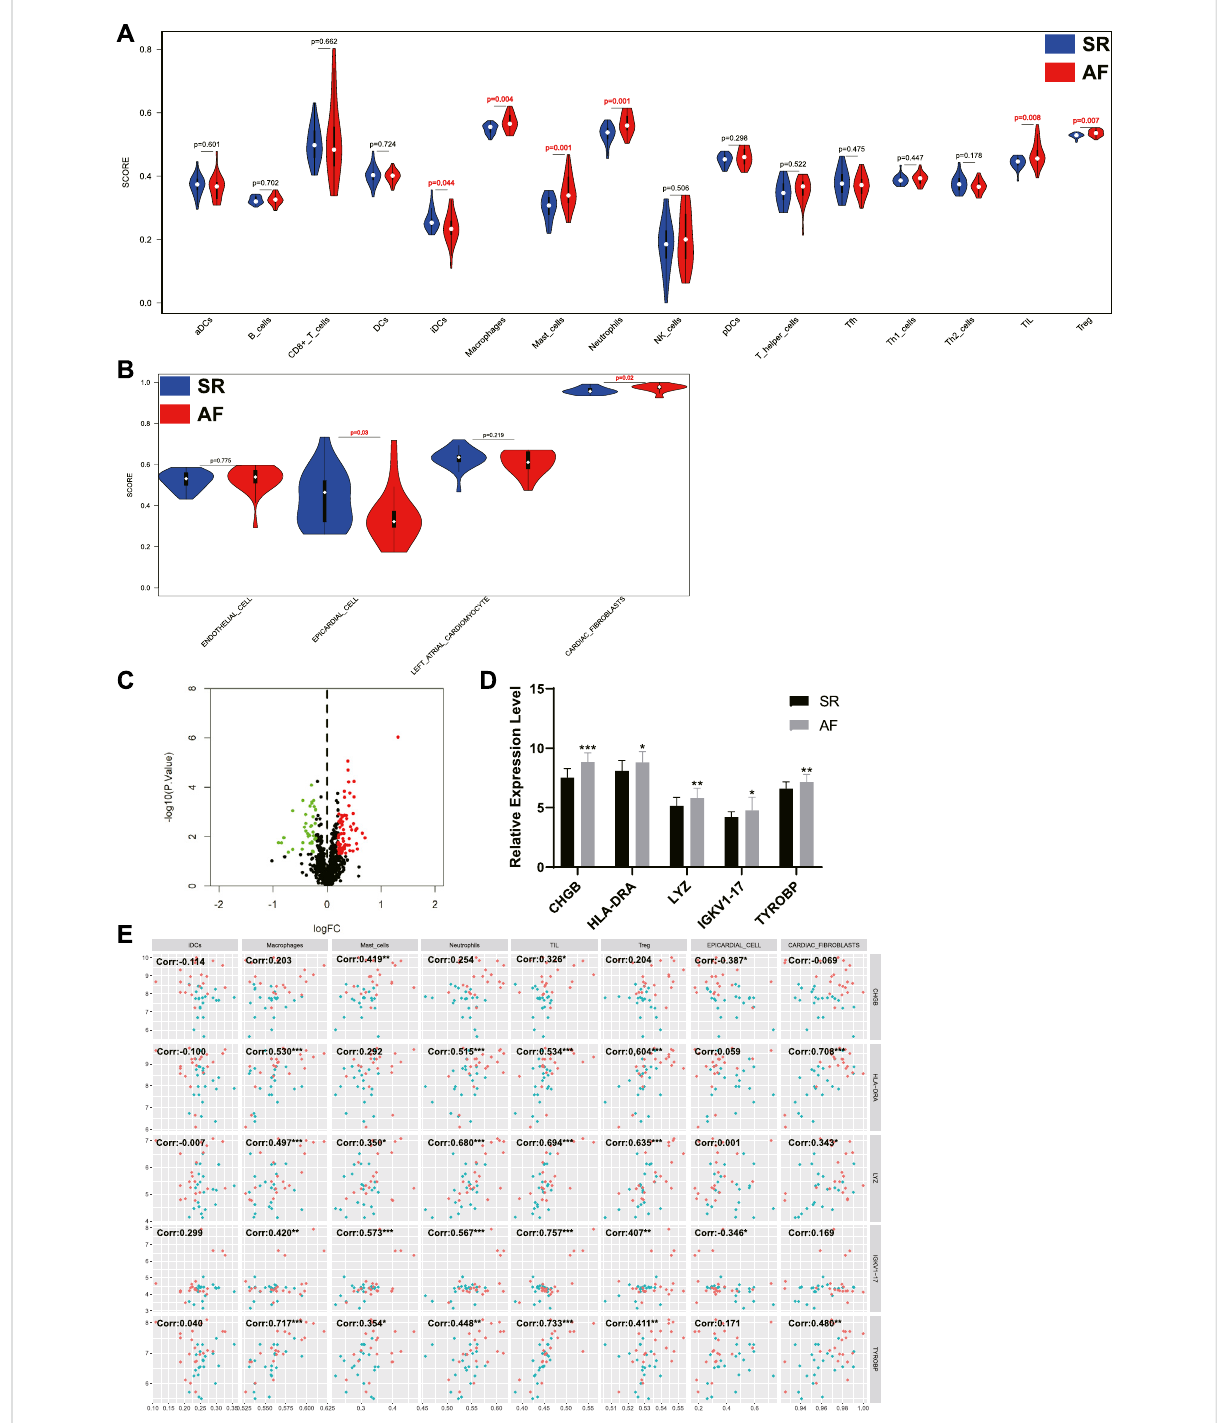
FIGURE 4 The analysis of immune cells and cardiac cells in LA samples and the correlation between immune genes, immune cells, and cardiac cells. (A) ThescoresofimmunecellsinLAsamples. (B) ThescoresofcardiaccellsinLAsamples. (C) Thevolcanoplotofdifferentiallyexpressedimmunegenes between patients with or without AF. Dots in green: downregulated gene, dots in red: upregulated gene. (D) The expression levels of top fi ve upregulatedimmunegenesinSRgroupandAFgroup. (E) Thecorrelationbetweenimmunegenes,immunecells,andcardiaccells.Dotsinblue: SR samples, dots in red: AF samples. LA: left atrium, SR: sinus rhythm, AF: atrial fi brillation. *, p < 0.05, **, p < 0.01, ***, p <